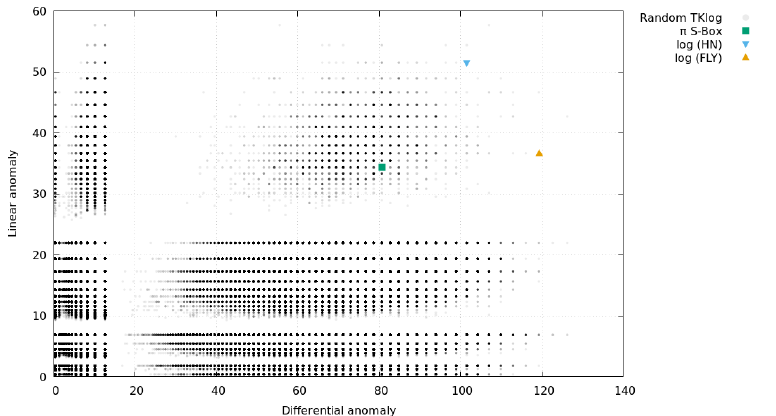
Figure 3: The differential and linear anomalies of random 8-bit TKlog instances, 𝜋 , log FLY and log HN 𝛼 𝛼